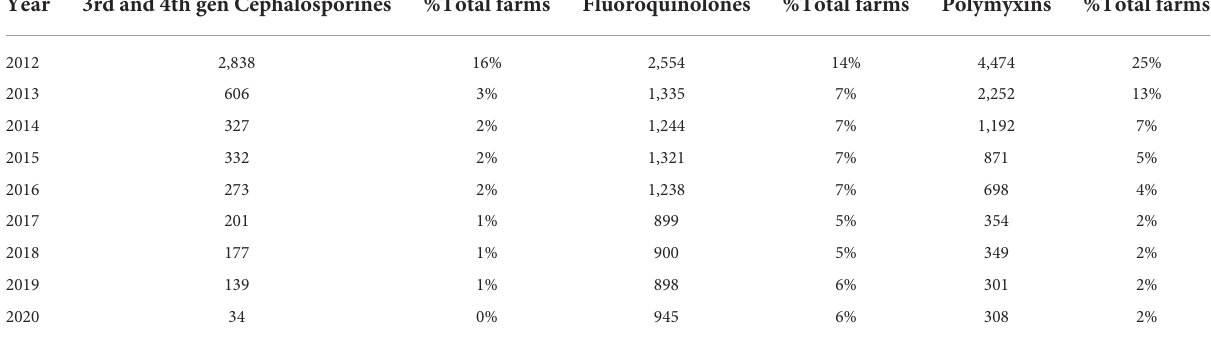
TABLE 4 Number of farms that consumed 3rd line products and polymyxins, from 2012 to 2020, their yearly variation and percentage in the whole sector.